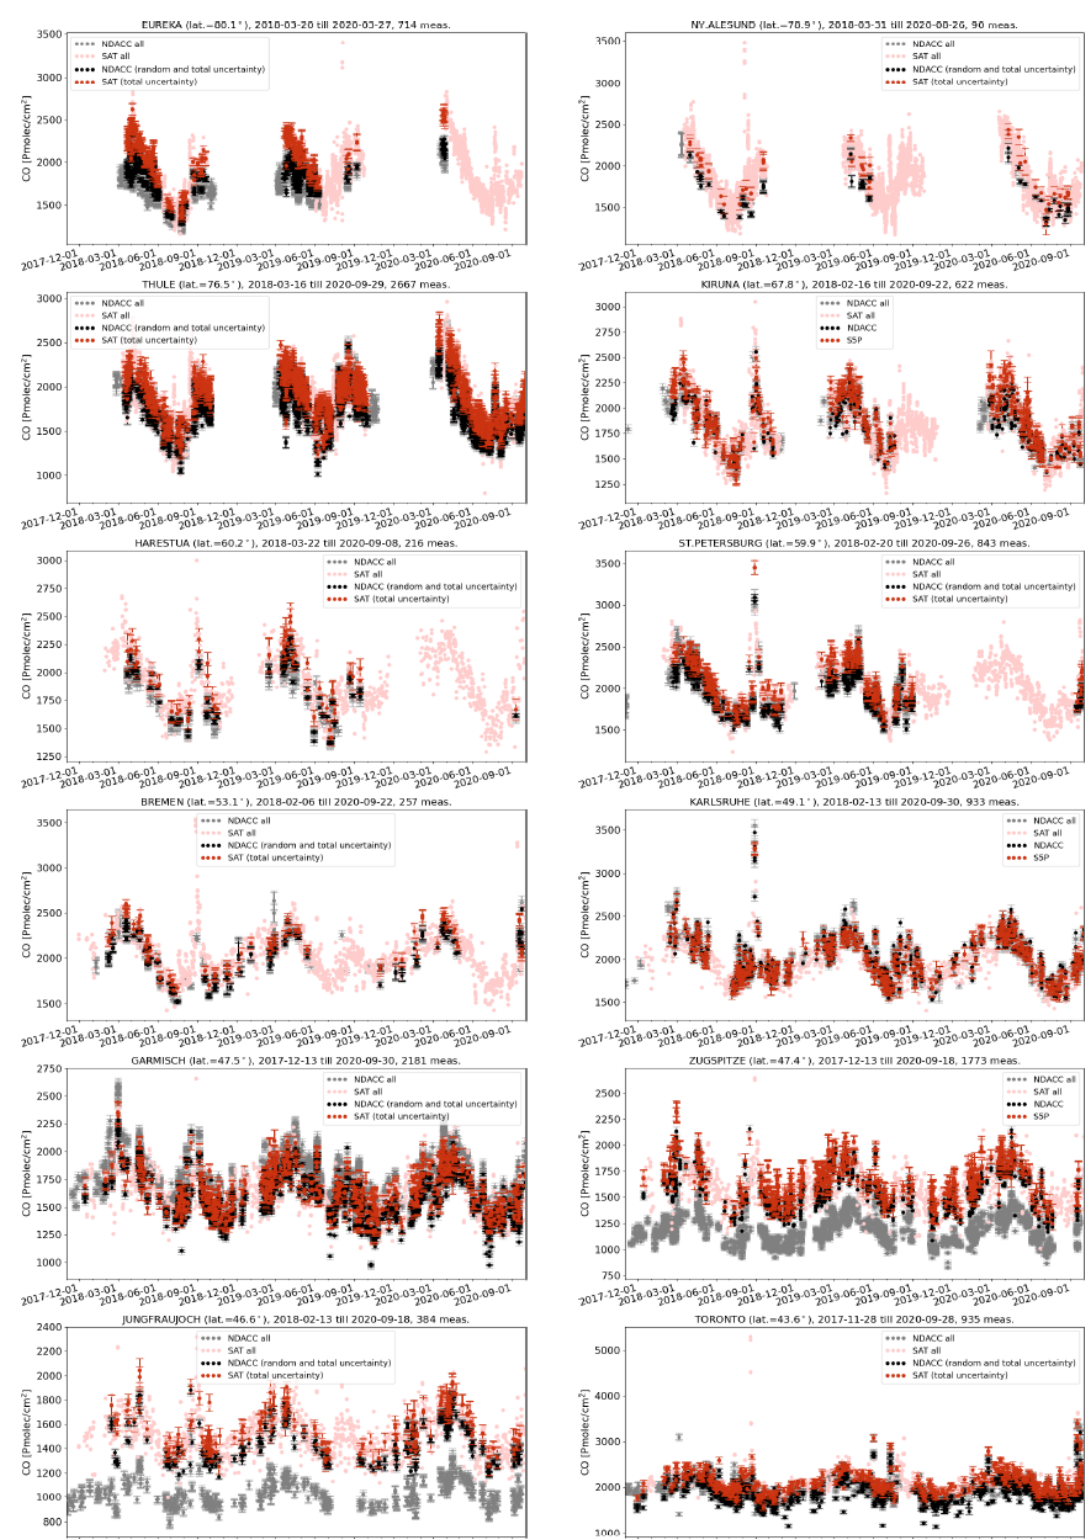
Figure 27. CO column time series for all NDACC data (grey), all S5P data (light red), S5P data co-located with NDACC data (red) and co-located NDACC data smoothed with S5P a priori and additionally smoothed with the S5P column-averaging kernel (black) at each site ordered with decreasing latitude. Spatial co-location with radius of 50km and time of ± 3h around the satellite overpass was